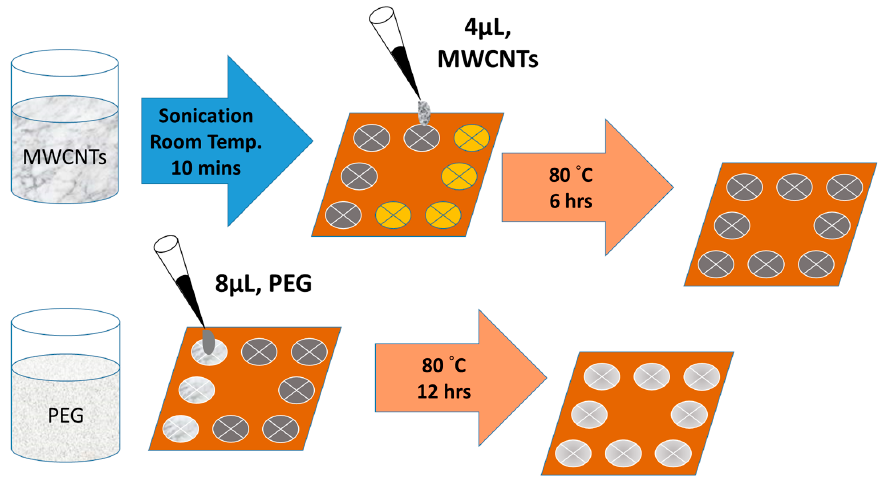
Figure 4. Fabrication process of the PEG/MWCNTs sensing film.